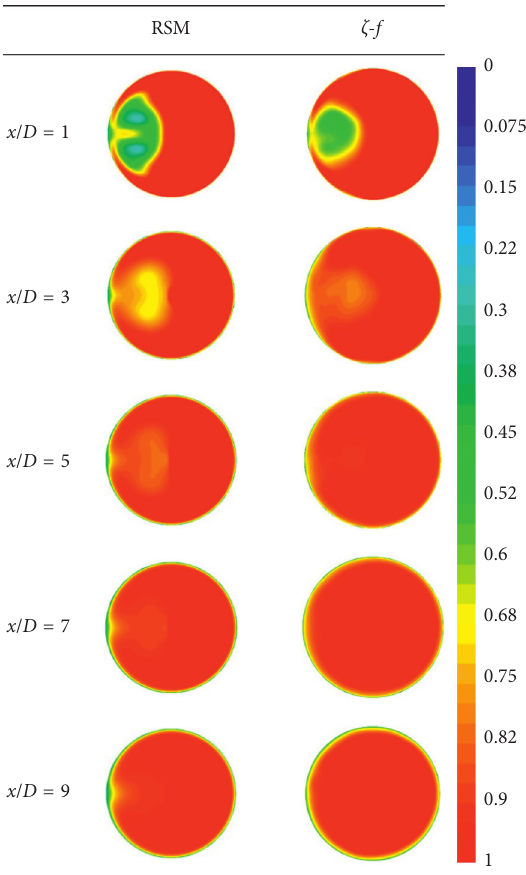
Figure 9: Normalized velocity contours. Comparisons of RSM and ζ - f